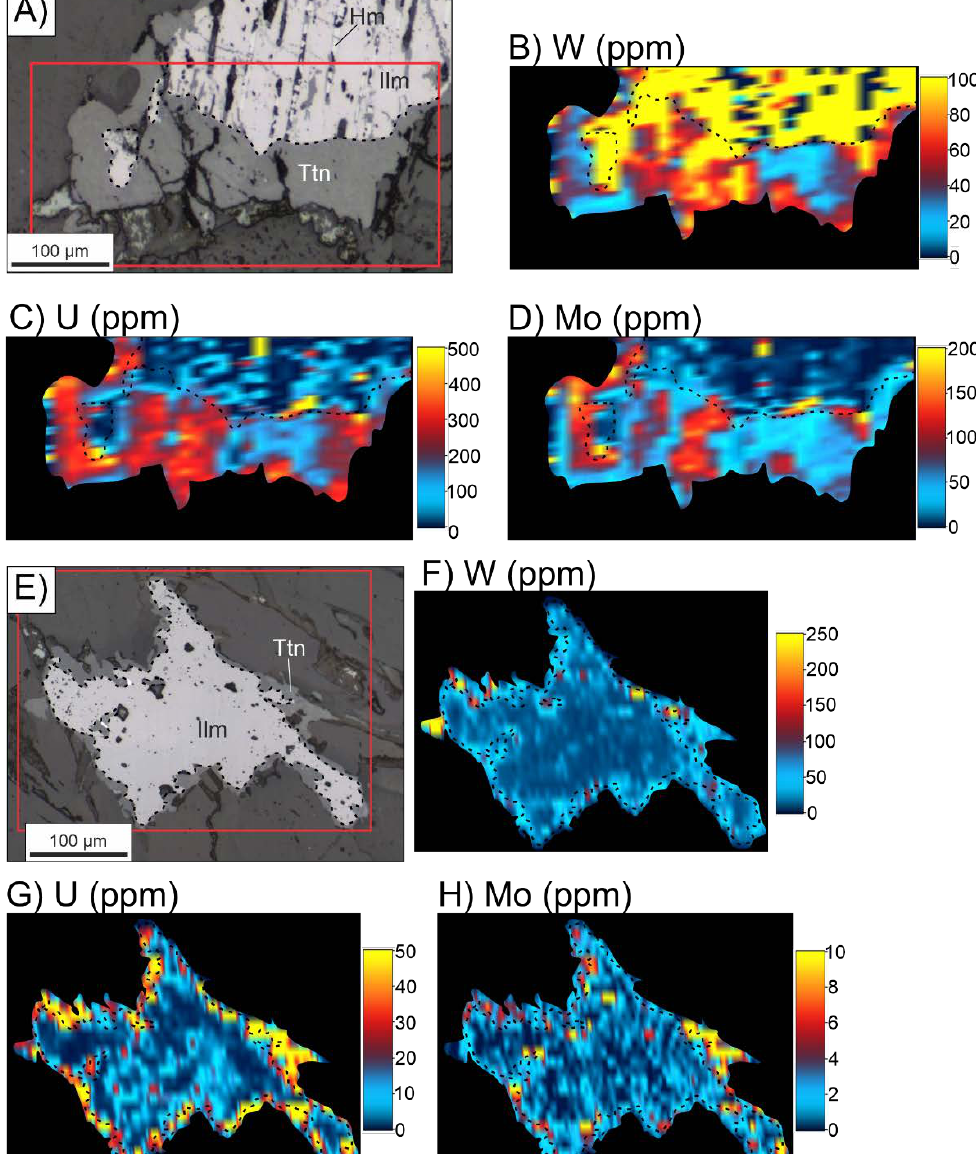
Figure 9. Petrographic images of LA ICP-MS maps of magmatic ilmenite mantled with titanite showing textures and elemental distributions of W, U, and Mo. Maps are not calibrated to single mineral and values are qualitative to allow comparison among various mineral phases. Minerals other than titanite and ilmenite have been masked, and the dotted line indicates the titanite-ilmenite interface. ( A ) Reflected light image showing titanite (Ttn) overgrowing ilmenite (Ilm) with hematite exsolution lamellae (Hm). Sample from granodiorite. Red box indicates area of LA ICP-MS mapping (sample from drill core SB0806 at 69 m), ( B ) laser ablation map of W, ( C ) laser ablation map of U, ( D ) laser ablation map of Mo. ( E ) Reflected light image of ilmenite (Ilm) mantled by titanite (Ttn) in gabbro. Red box indicates area of LA ICP-MS mapping (sample from drill core SB0834a at 84.6 m), ( F ) laser ablation map of W, ( G ) laser ablation map of U, ( H ) laser ablation map of Mo. Three grains of magmatic titanite were mapped from a single thin section of diorite (SB0806-69